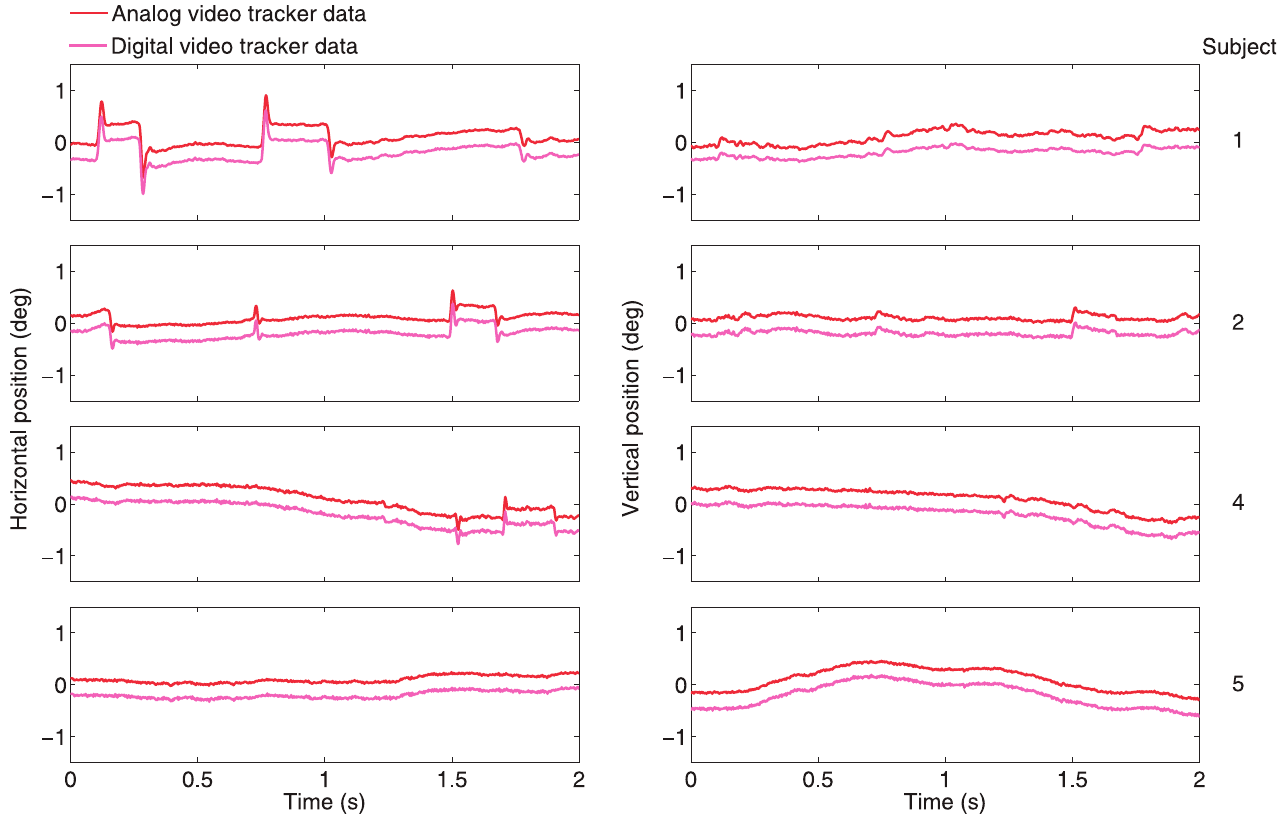
Fig 1. Comparison of data recorded from the analog versus the digital output of the video tracker. A two second epoch of analog versus digital eye movement recordings for each subject (indicated at the right) for the horizontal (left) and vertical (right) eye positions. Red traces are the digital signals obtained from the analog output of the video tracker as described in the Methods section. Pink traces are the corresponding data obtained from the digital output of the video tracker. Both signals are nearly identical.